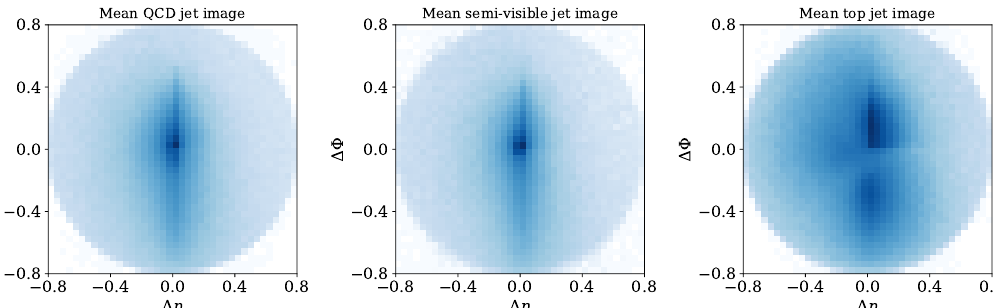
Figure 2: Average jet images in the plane of pseudo-rapidity η and azimuthal angle φ for light QCD (left), semi-visible dark jets (middle), and boosted top jets (right). See appendices A and B for details on the event generation and the preprocessing steps for the generation of the